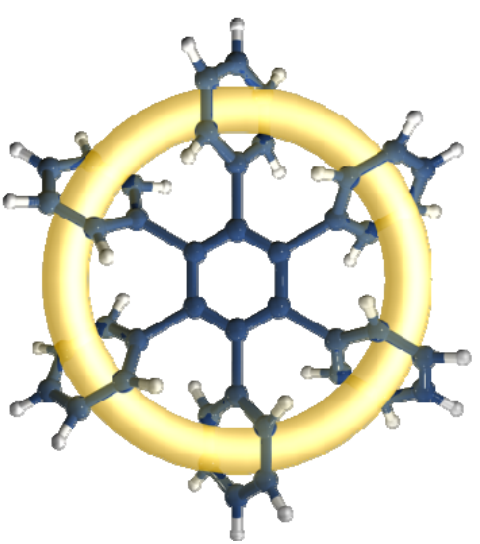
Figure 1. Toroidal